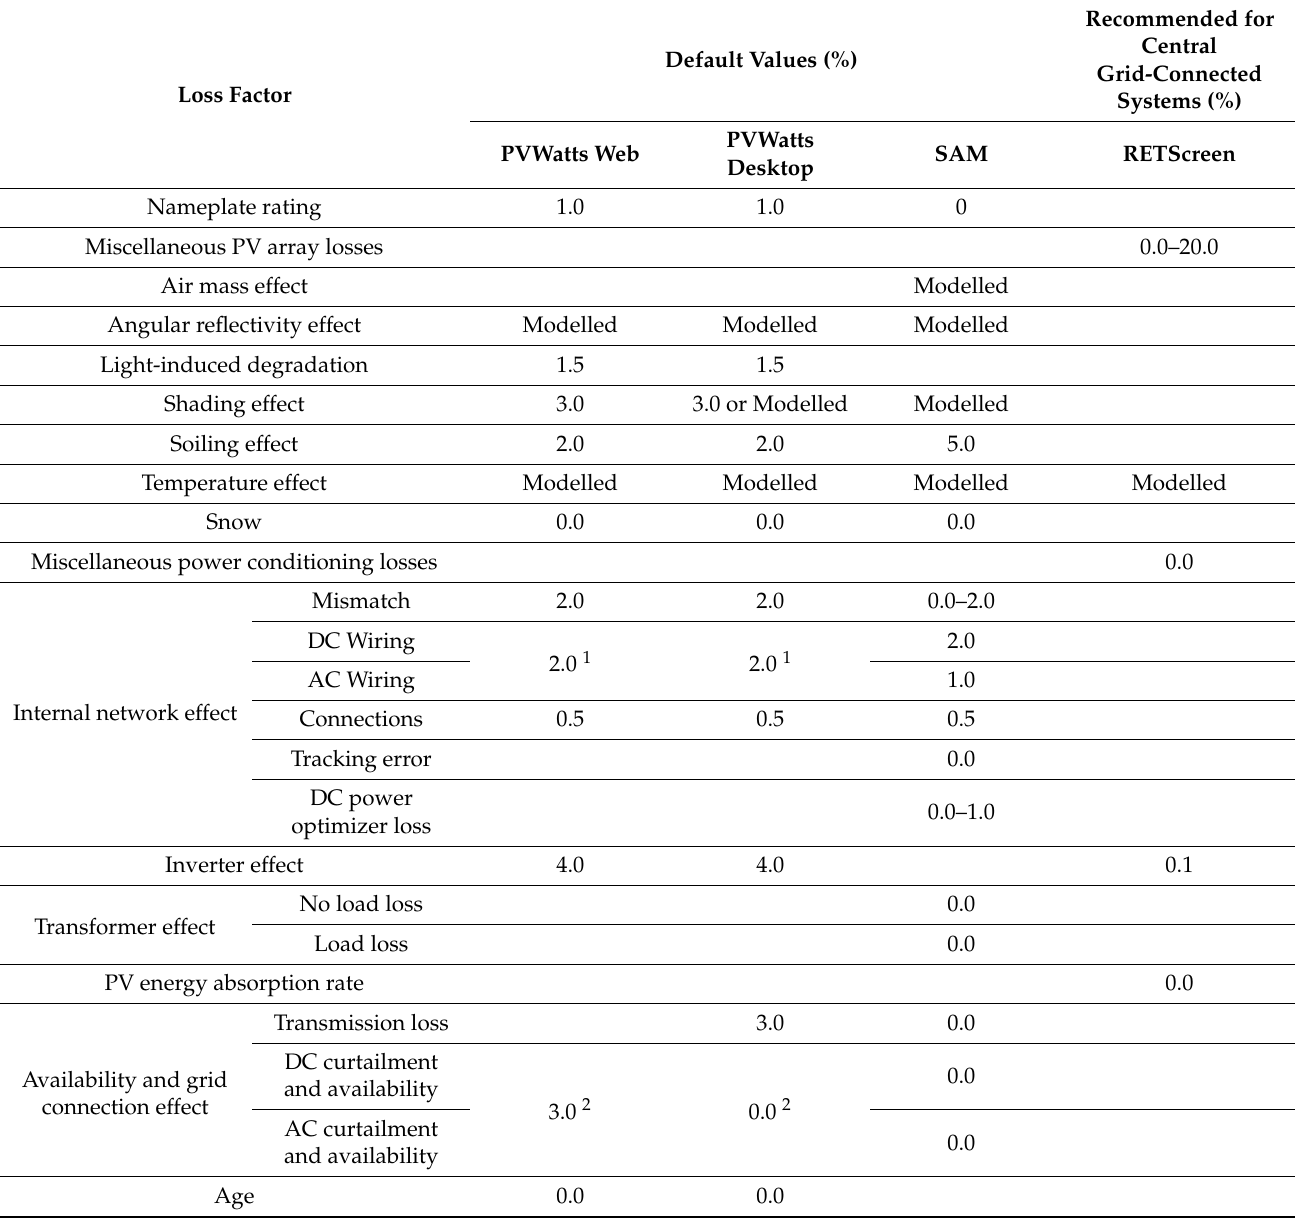
Table 1. Summary of default derate factors and modelled losses for PVWatts, SAM and